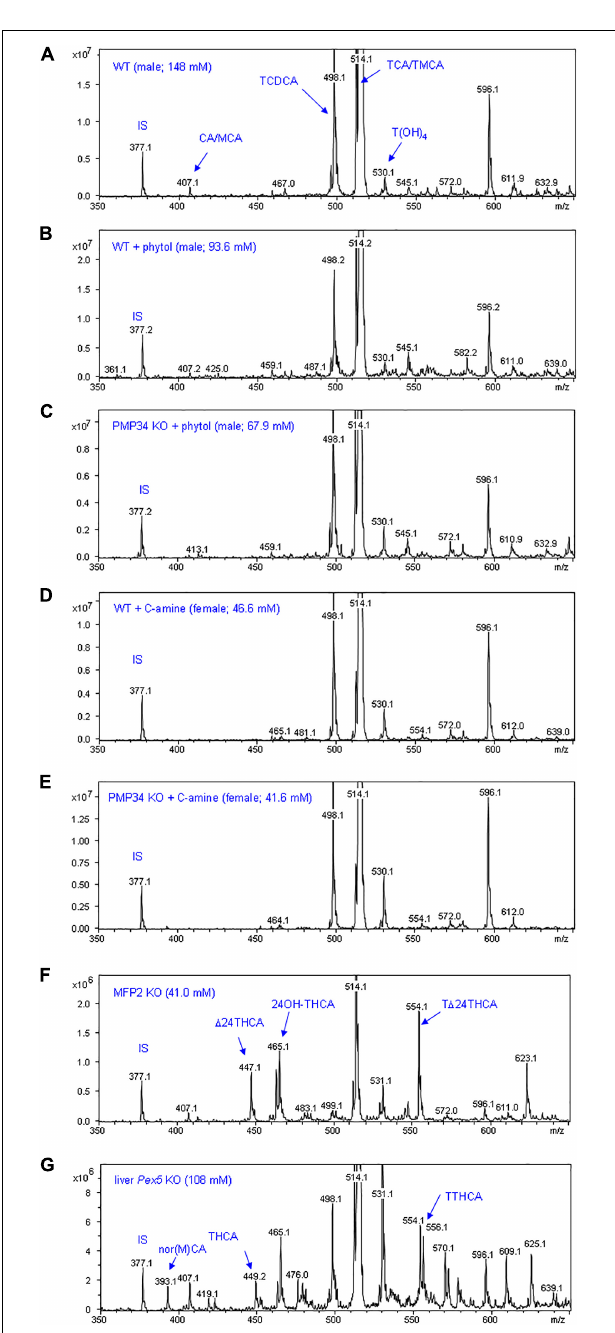
FIGURE 9 | Biliary bile acid profiles of PMP34 KO mice. Panels (A–E) show MS-scans [350-650 m/z; negative mode; smoothed (0.2; 1; GA)] of bile obtained from wild type or PMP34 KO mice fed a normal or a phytol enriched diet or treated with cholesterylamine (C-amine) (gender and concentration of biliary bile acids of the individual animals is indicated in parentheses). Murine bile contains mainly tauro-conjugates, the major ones being tauromuricholic acids (TMCA, a,p-isomers) and taurocholic acid (TCA), both same m/z 514 (signal topped in all panels), followed by taurochenodeoxycholic acid (TCDCA, m/z 498) and a taurotetrahydroxycholanic acid (T(OH) 4 , m/z 530) (IS, 23-nor-3a,12a-dihydroxy-5p-cholanoic acid, m/z 377). The ion with m/z 596 represents a Na-acetate adduct of m/z 514; non-conjugated bile acids (cholic